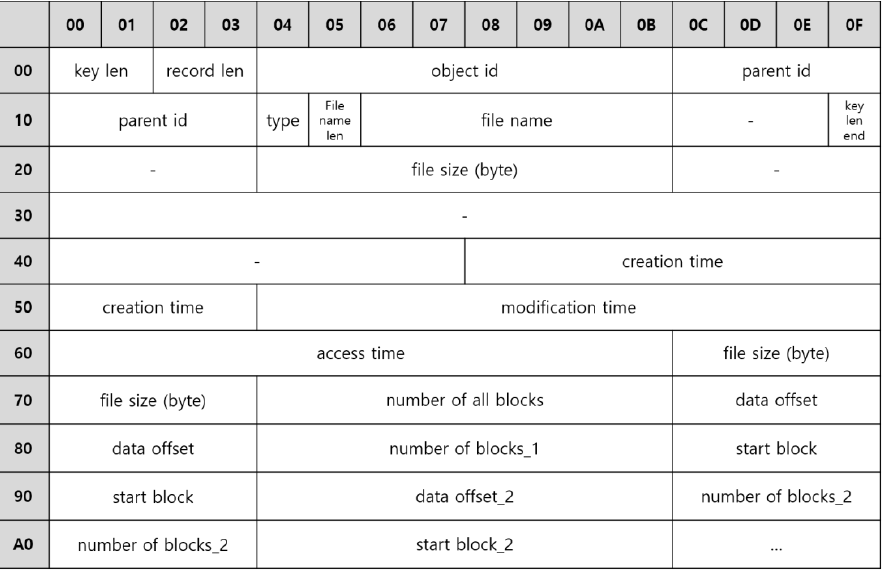
Figure 7. The airplay-service.md file records in a catalog tree with magic number 0x644E.